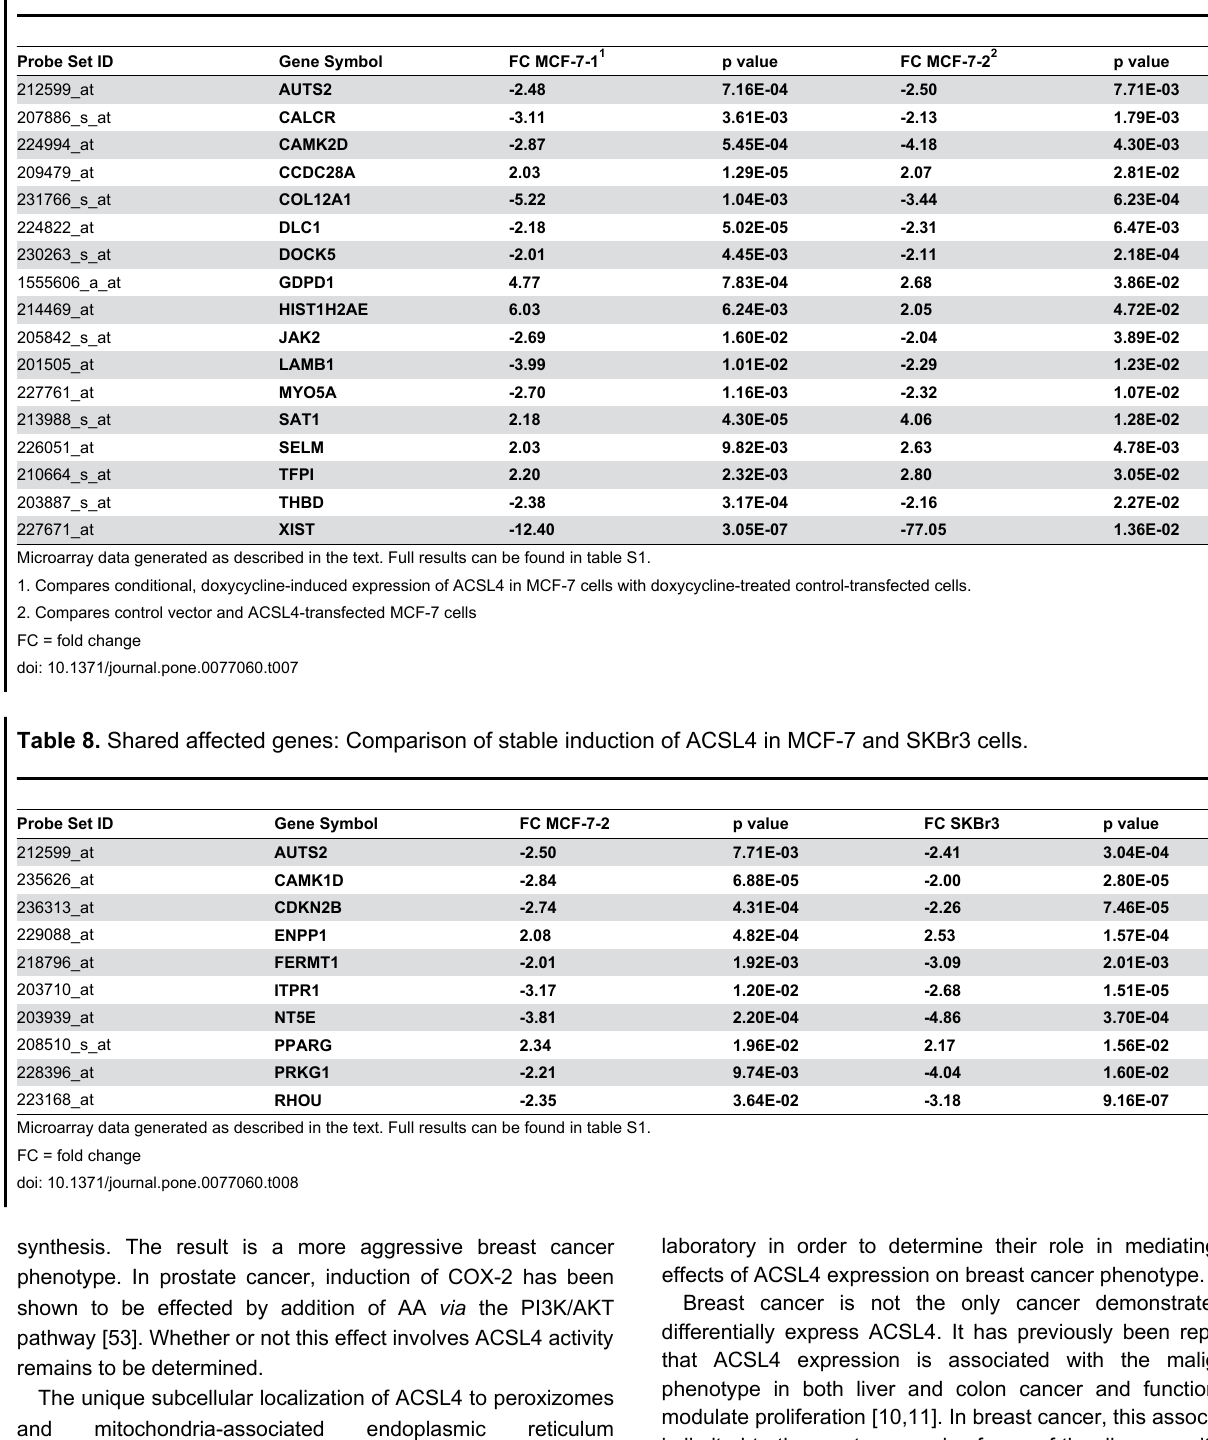
Table 7. Shared affected genes: Comparison of conditional and stable induction of ACSL4 in MCF-7 cells.